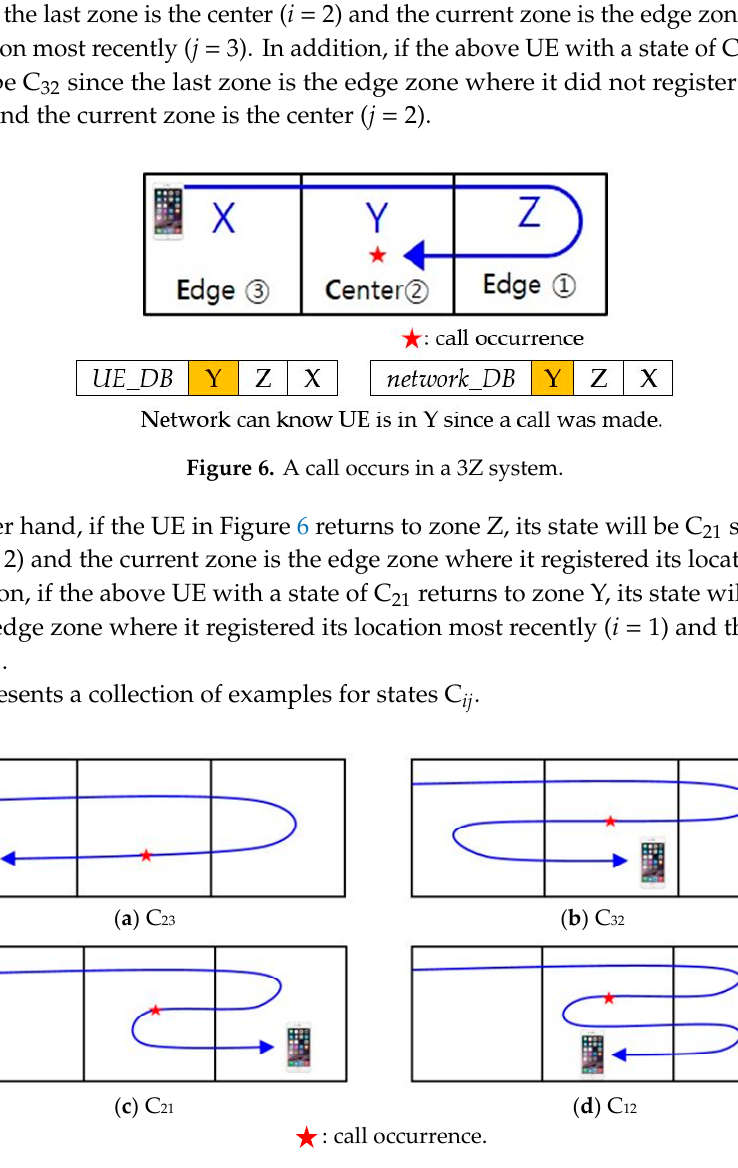
Figure 5. Examples of states I ij . : ( a ) I 12 ; ( b ) I 21 ; ( c ) I 32.